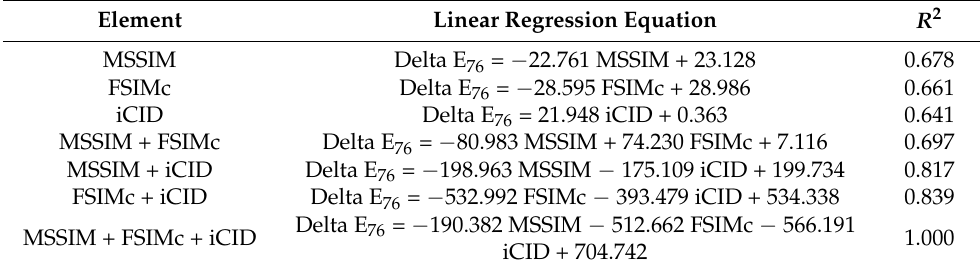
Table 9. Linear regression equation using the CIEDE1976 color difference mode.